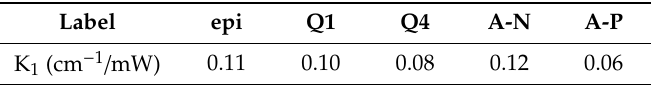
Table 4. K 1 value for tested samples with exciting line at 325 nm.